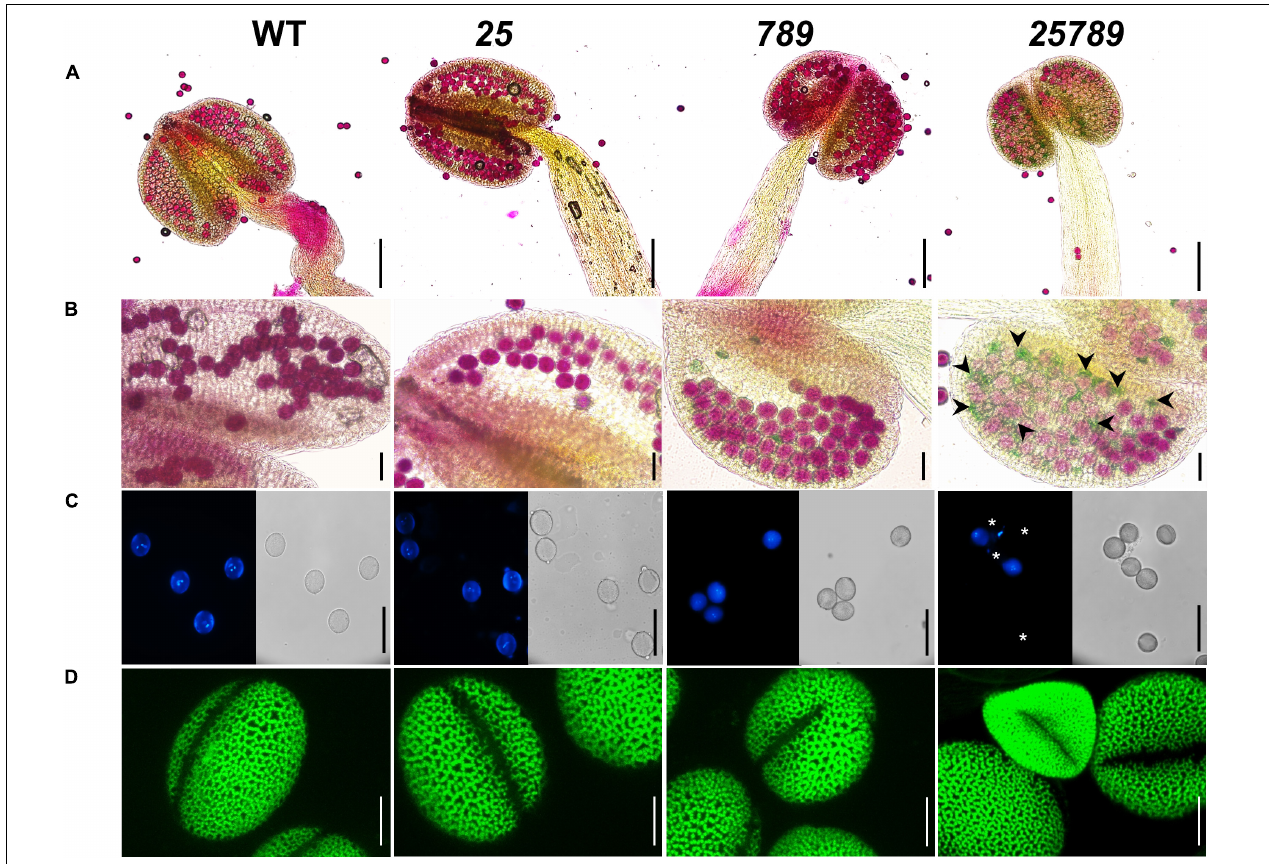
FIGURE 3 | Characterization of pollen grain defects by alexander, DAPI, and auramine-O staining of Hyp-GALT mutants compared to WT. (A) Complete view of anther showing pollen viability of WT, galt25 , galt789, and galt25789, accessed by alexander staining. (B ) High magnification view showing alexander staining of pollen grains. galt25789 had abnormal aborted pollen (indicated by green-colored pollen and black arrowheads in panel). (C) DAPI staining of mature pollen grains released from anthers, under a light microscope and a DAPI filter. Mature pollen grains detected the presence of two sperm nuclei and one vegetative nucleus in WT, galt25 and galt789 and galt25789 except for the aborted pollen grains (indicated by white asterisks) in galt25789 mutant. (D) Confocal images of pollen stained with 0.1% auramine-O in WT, galt25 and galt789 and galt25789 . Scale bars = 200 µ m in (A) ; 50 µ m in (B,C) ; 10 µ m in panel (D)